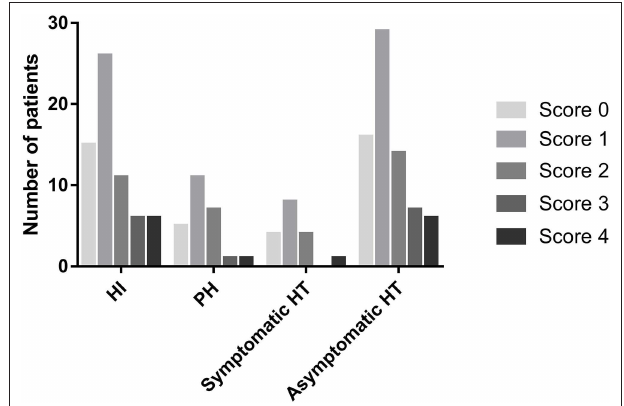
FIGURE 4 | Numbers of patients presenting with different cerebral SVD scores, categorized by the subtypes of